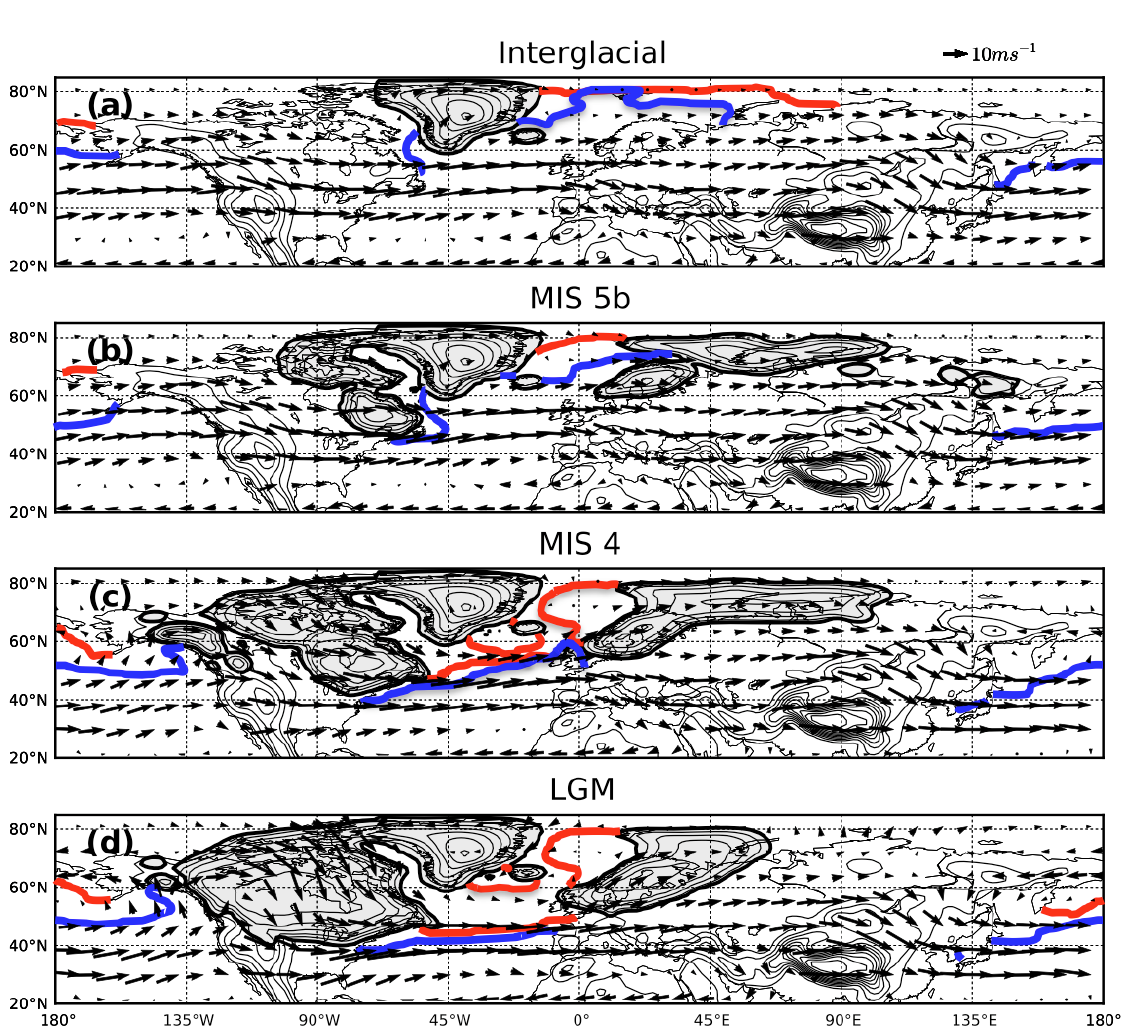
Figure 2. Evolution of the Northern Hemisphere topography over the glacial cycle (shading of ice sheets). The contour interval is 500m and the outer contour line defines the edge of the ice sheets. The arrows show the wind vectors in winter along a model level (the nominal 800hPa surface) and the blue (red) line the 50% sea-ice margin in winter